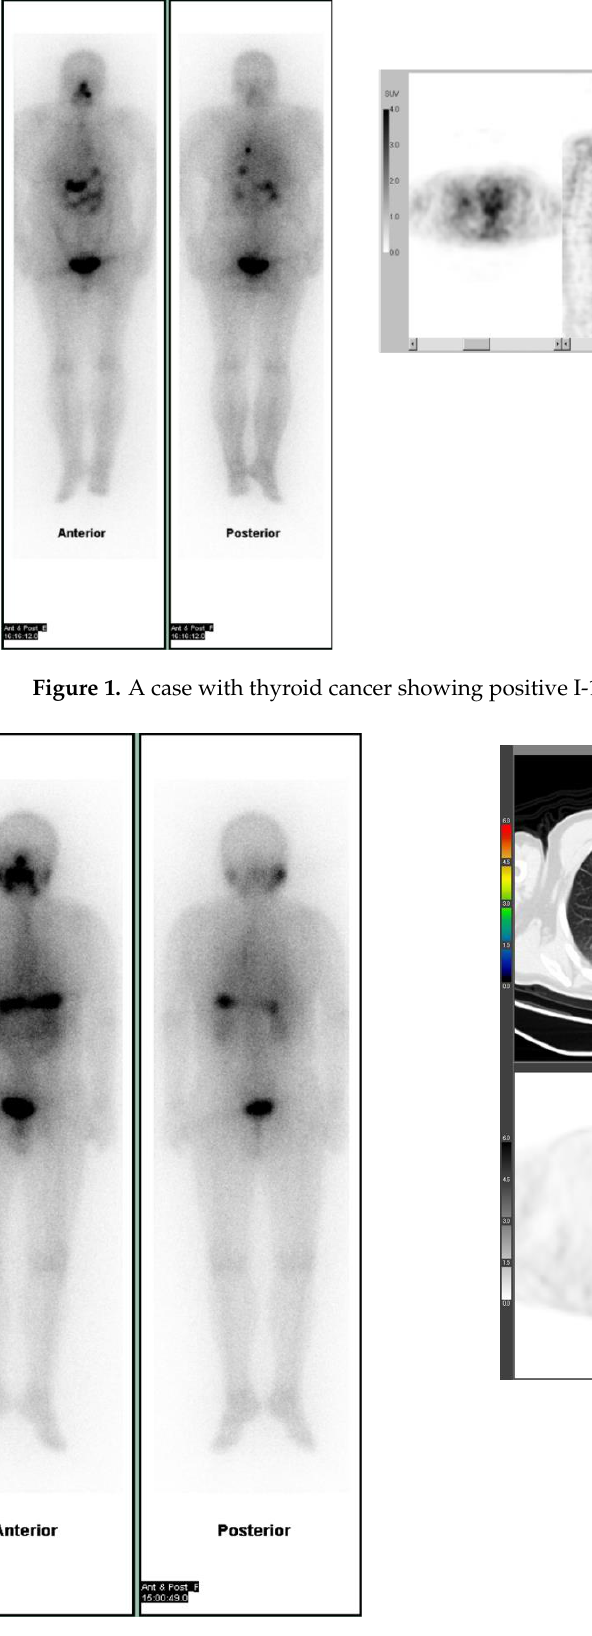
Figure 2. A case with thyroid cancer showing negative I-131 and positive FDG uptake in the lung.